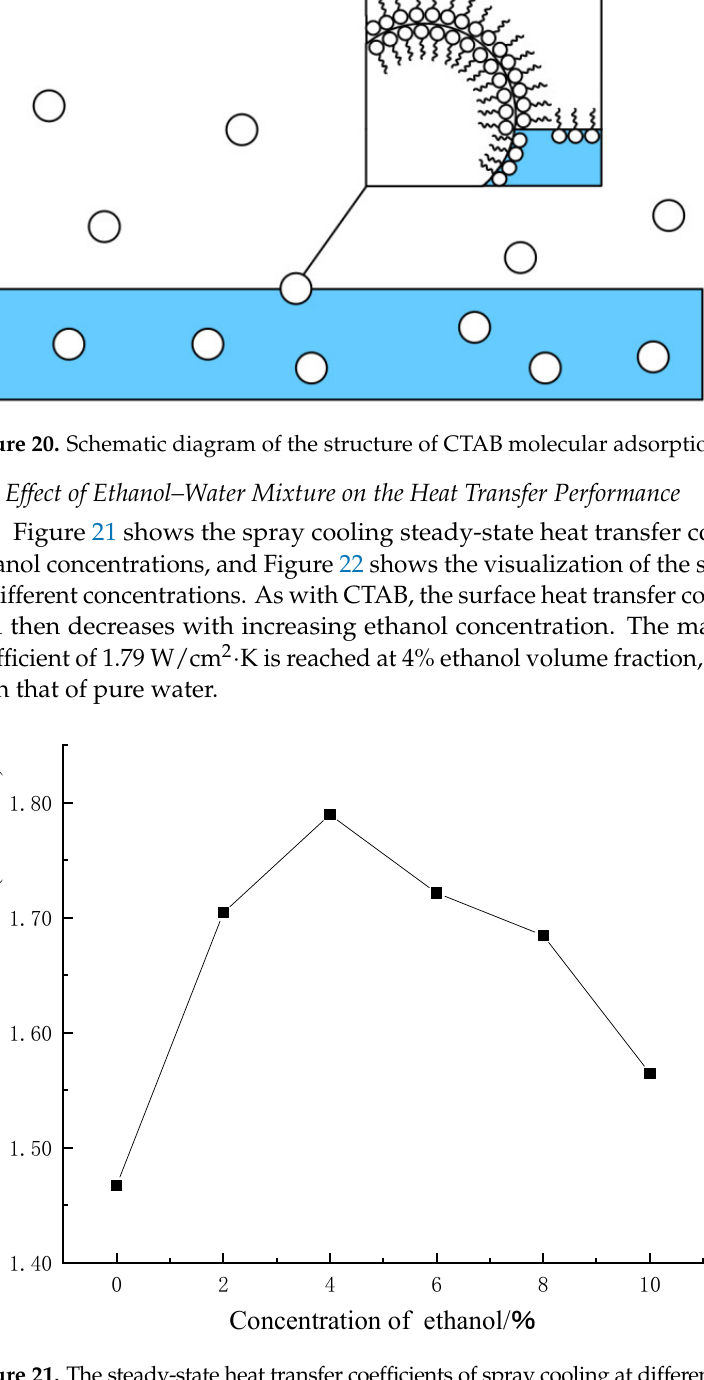
Figure 21. The steady-state heat transfer coefficients of spray cooling at different ethanol concentrations. The increase in the heat transfer coefficient of the ethanol–water mixture can be attributed mainly to the evaporation of ethanol. The evaporation of ethanol at a lower surface temperature produces a vapor nucleus that acts as a secondary nucleus for the evaporation of the fluid, which is more likely to trigger the phase change of the liquid film on the heated surface and can significantly increase the heat transfer coefficient of the surface. In addition, the addition of ethanol also decreases the surface tension and contact angle of the fluid, and the droplets are more likely to break, which enhances the forced convection on the surface. The boiling point of the mixture decreases with